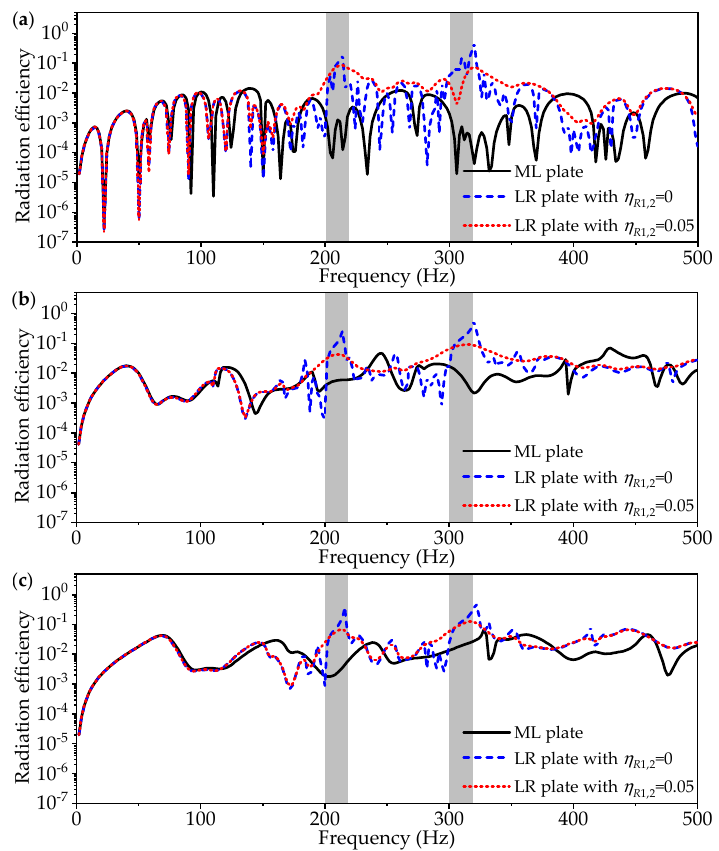
η = ), with 0.05 1,2 R